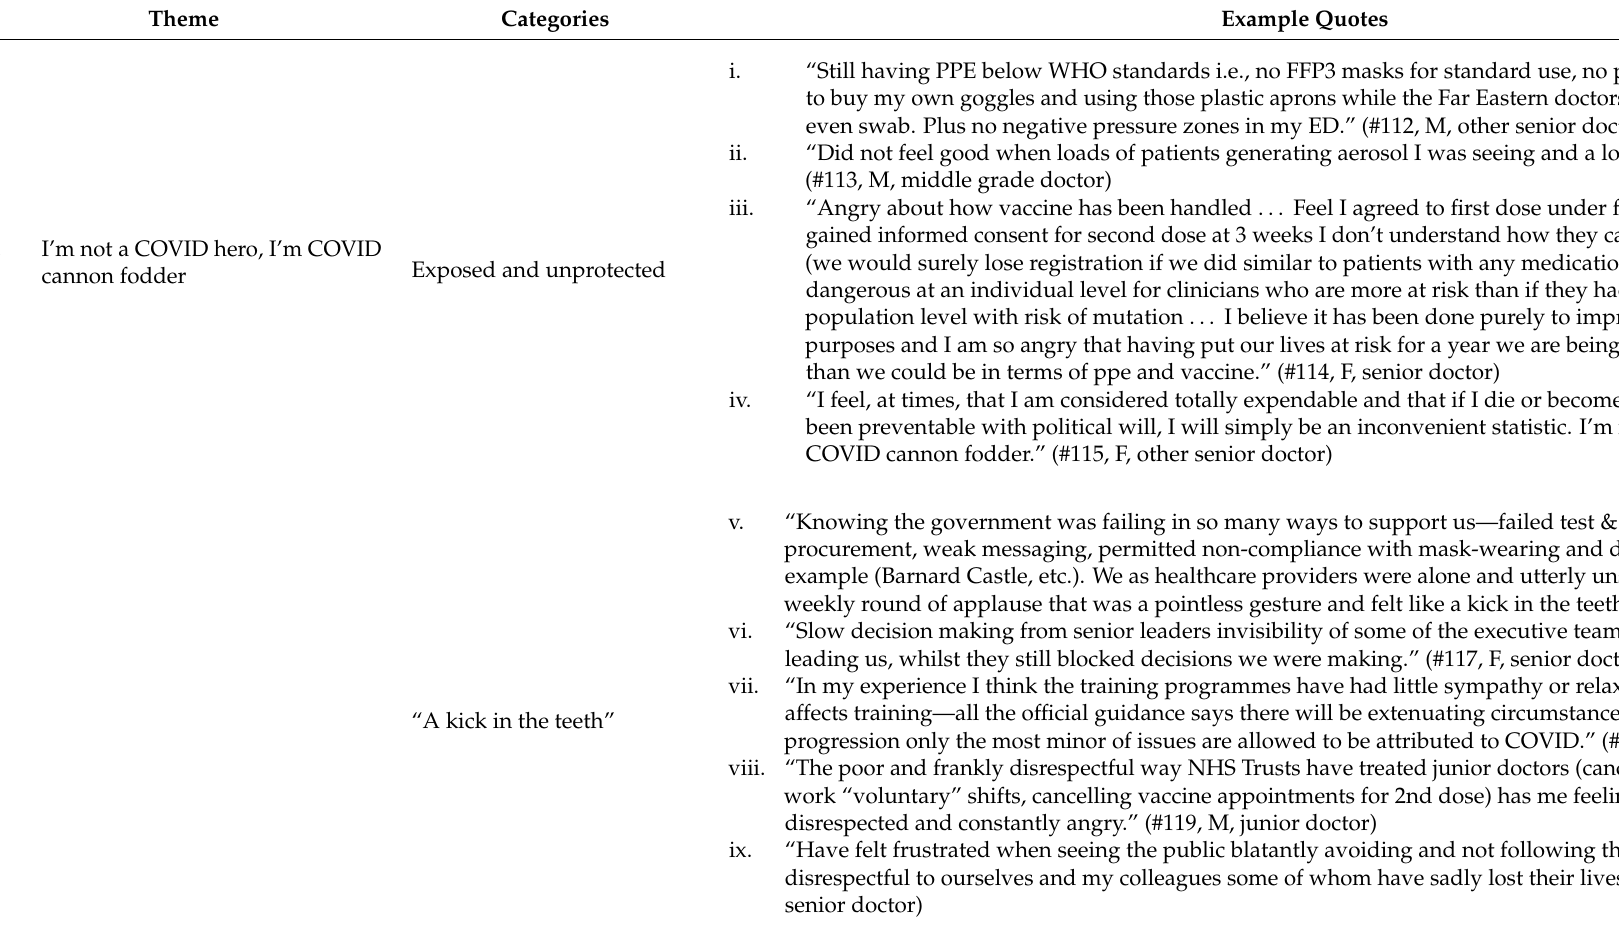
Table 2. Themes, categories, and example